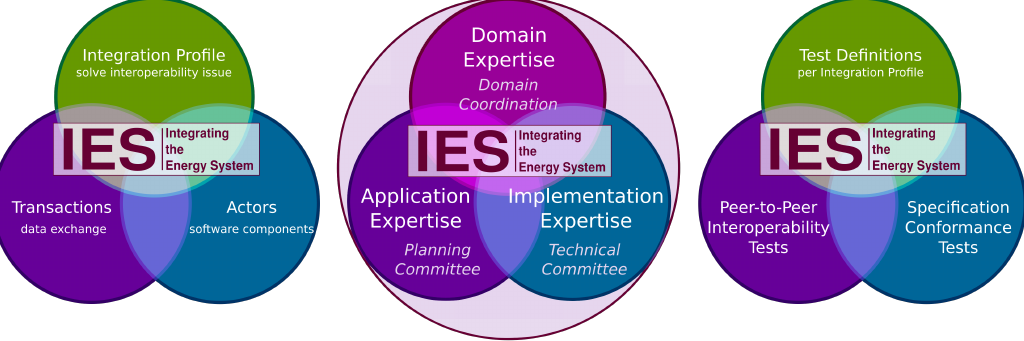
Figure 6. Functional Committees: coordinating, managing, and executing bodies that drive and manage the IES based process to integrate energy